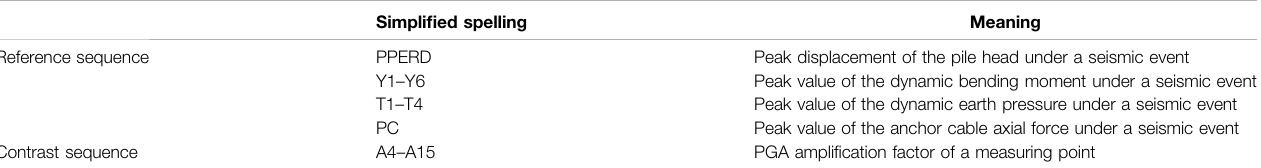
TABLE 5 | Summary of the fuzzy gray relational analysis sequences.